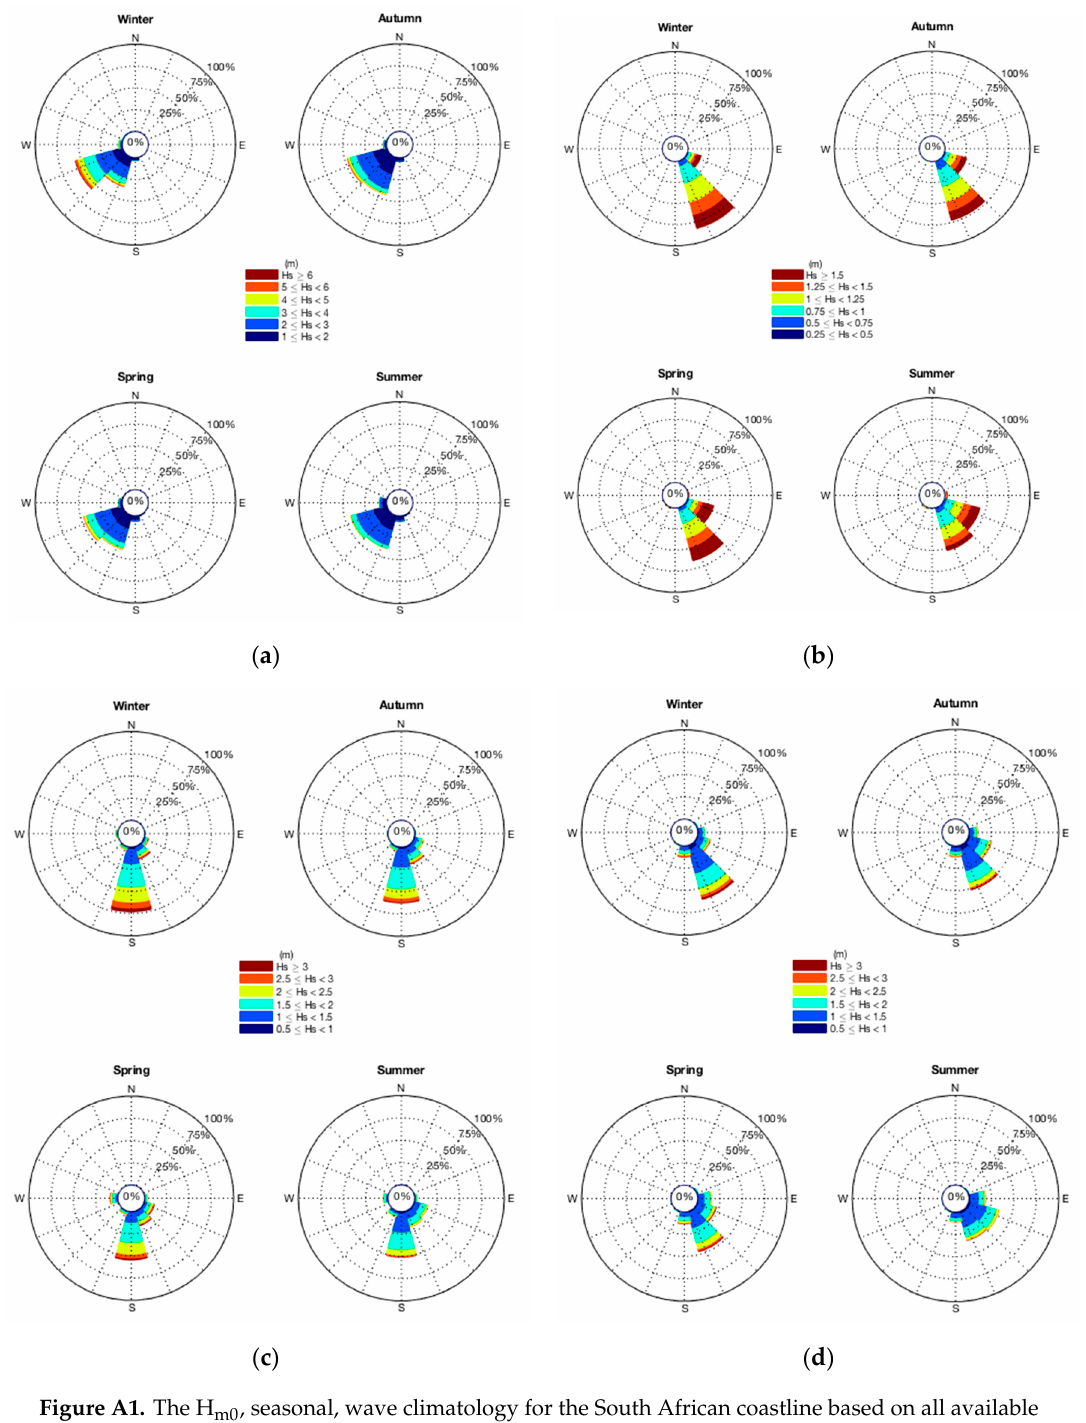
Figure A1. The H m0 , seasonal, wave climatology for the South African coastline based on all available in situ wave rider buoy data at ( a ) Slangkop (Cape Town), ( b ) Port Elizabeth, ( c ) East London, and ( d ) Richards Bay.